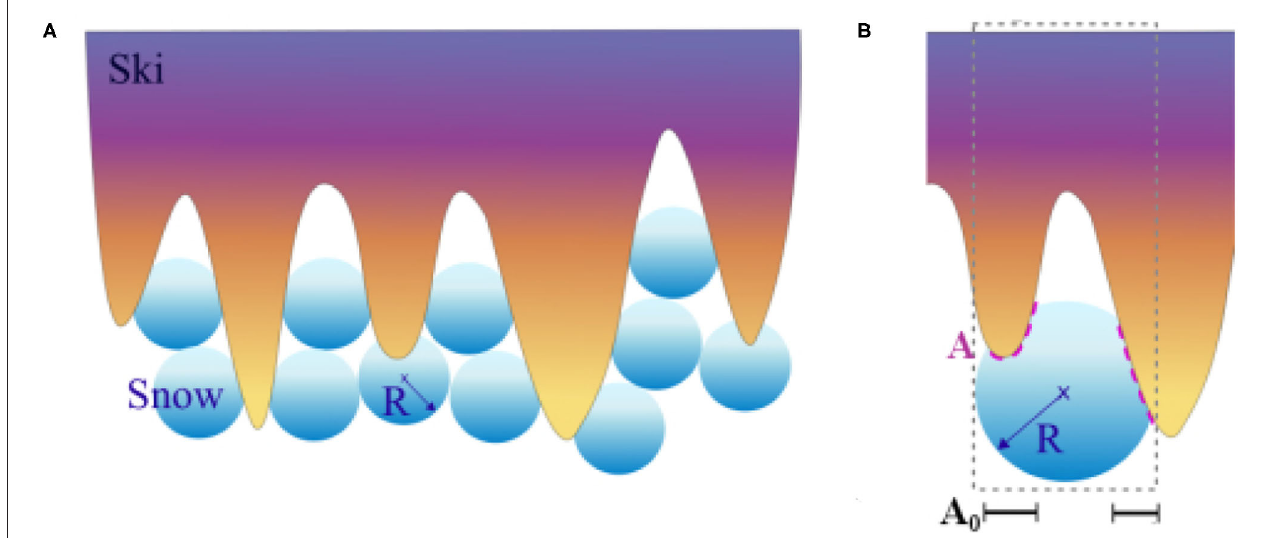
FIGURE 2 | Model of the ski-snow contact. Snow consisting of unsintered, loose snow grains is considered. These grains move freely against each other and fill the ski base topography. In (A) , the filling process is schematically illustrated with snow grains modeled as spheres having a certain radius R . In (B) , it is shown, how the real contact area A is calculated when a single snow grain is pressed into a ski topography valley. The softer grain deforms plastically and the real contact area A between ski and snow is determined as the surface of the harder material (the ski) that is wrapped by the softer material (the ice). Projecting A on the sliding plane yields A 0 , the projected area of contact. Finally, the fractional contact area is calculated as A fr = A . R 2